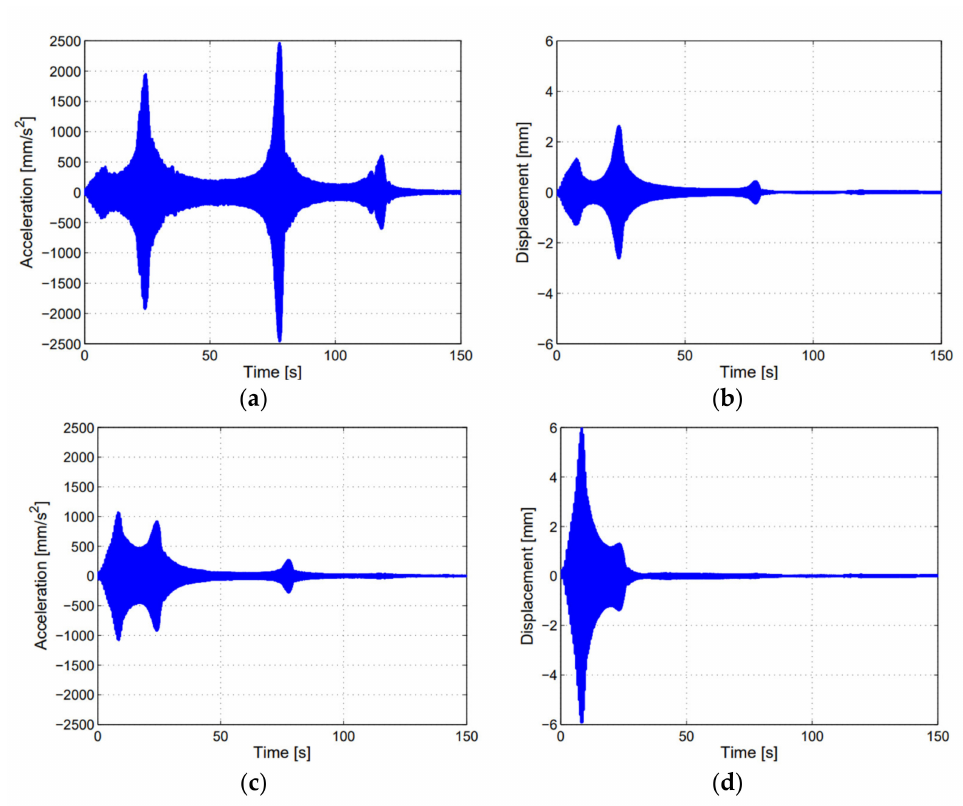
Figure 12. Increasing SS. FTMD configuration, time histories: ( a ) absolute acceleration at support level; ( b ) relative displacement at support level; ( c ) absolute acceleration at 4th floor; ( d ) relative displacement at 4th floor.